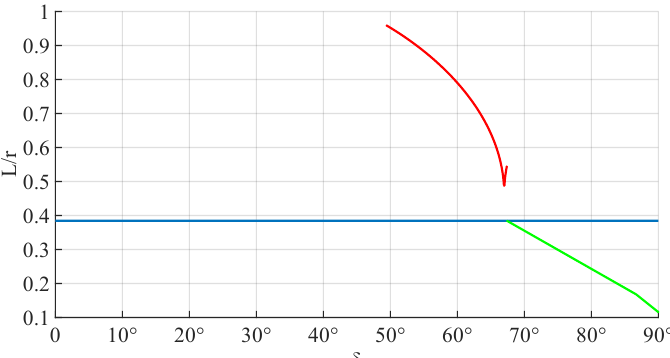
Figure 8. Contact distance under transformable state C 1 and C 2 L / r (5 mm) (Blue: wheel state; Red: